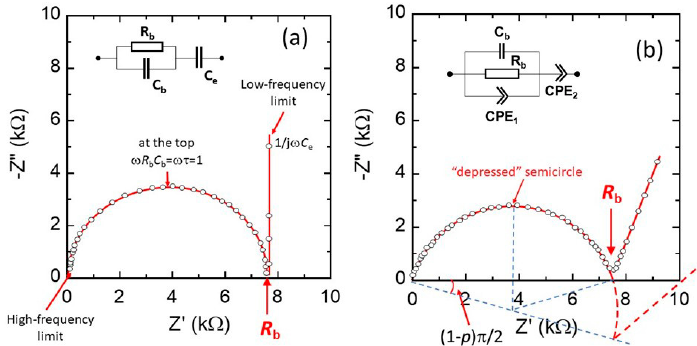
Figure 3. ( a ) Nyquist impedance plot of an idealized fast-ionic conductor (FIC). The semicircle centered at R b / 2 represents the response of the R b , C b parallel element and straight line is the capacity of the electrolyte / electrode interface of impedance 1 / j ω C e . ( b ) Nyquist impedance plot of a FIC sample. The depressed semicircle reflects the combination of R b , C b , CPE 1 and the inclined straight line represents the double-layer capacity of the inhomogeneous electrode surfaces.